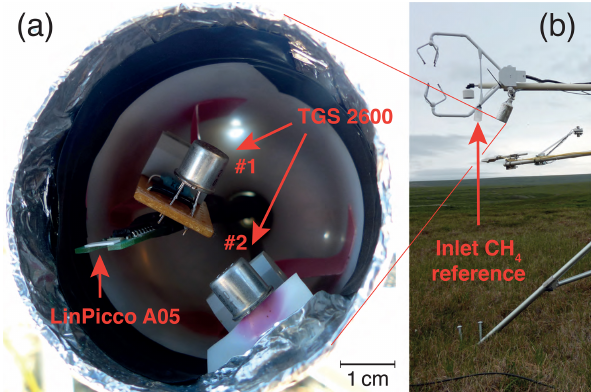
Figure 1. Two TGS 2600 trace gas sensors and the LinPicco A05 temperature and relative humidity sensor (a) inside the weather pro- tection and (b) the mounting position of the TGS weather protection and reference CH 4 gas inlets at the Toolik wet sedge eddy covari- ance flux